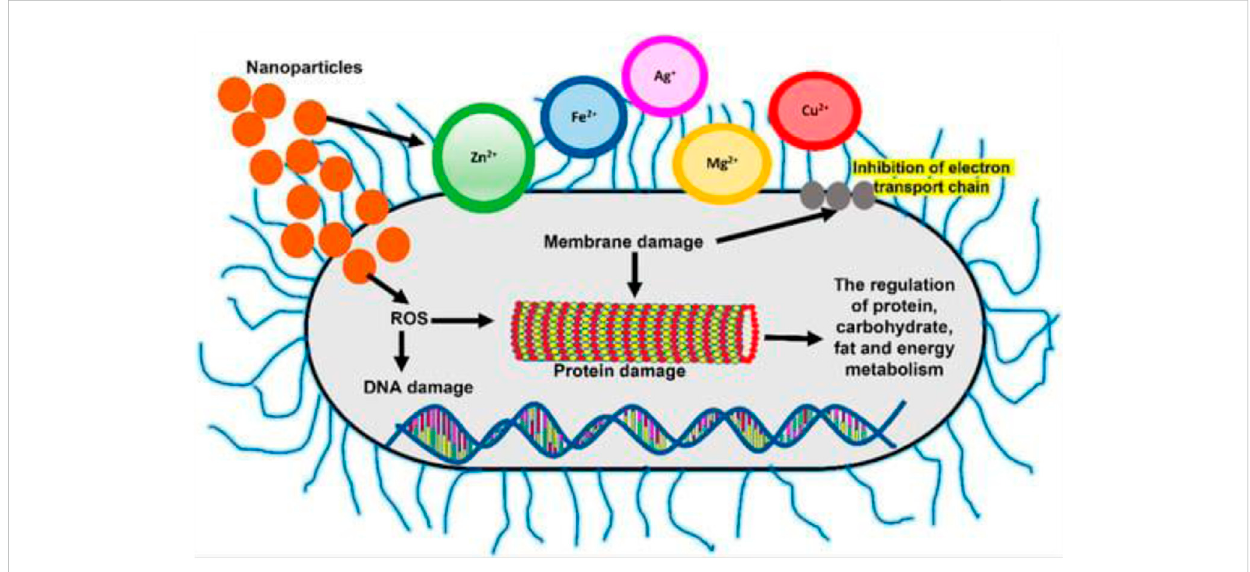
FIGURE 3 Changes in free radical generation and membrane permeability, which cause protein and DNA damage, are two mechanisms of NPsactivity in bacterial cells (L. Wang et al.,